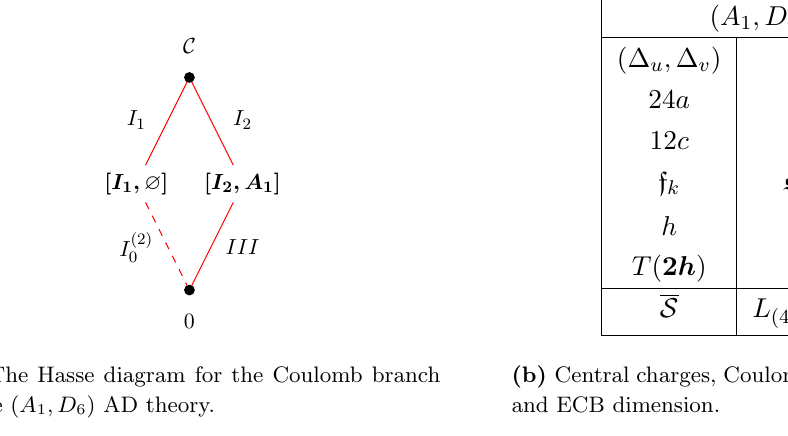
Figure 12. Information about the ( A 1 ; D 6 ) AD